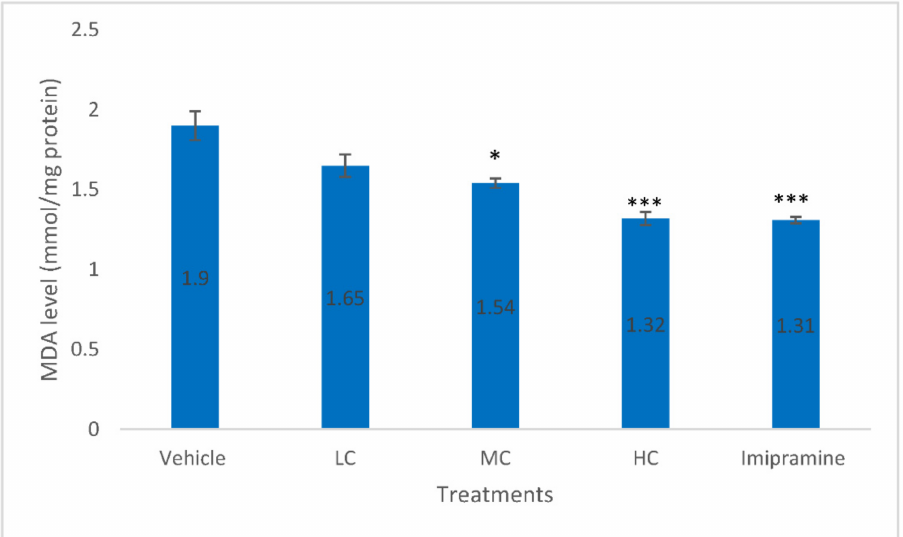
Figure 5. The changes on brain MDA level due to crocin and imipramine. Data were given as mean and standard error of mean. Each group had eight animals. Statistical analysis was performed by one-way analysis of variance (ANOVA) and post-ANOVA Tukey’s test; * p < 0.05, and *** p < 0.001 when compared to vehicle; LC—low dose of crocin; MC—medium dose of crocin; HC—high dose of